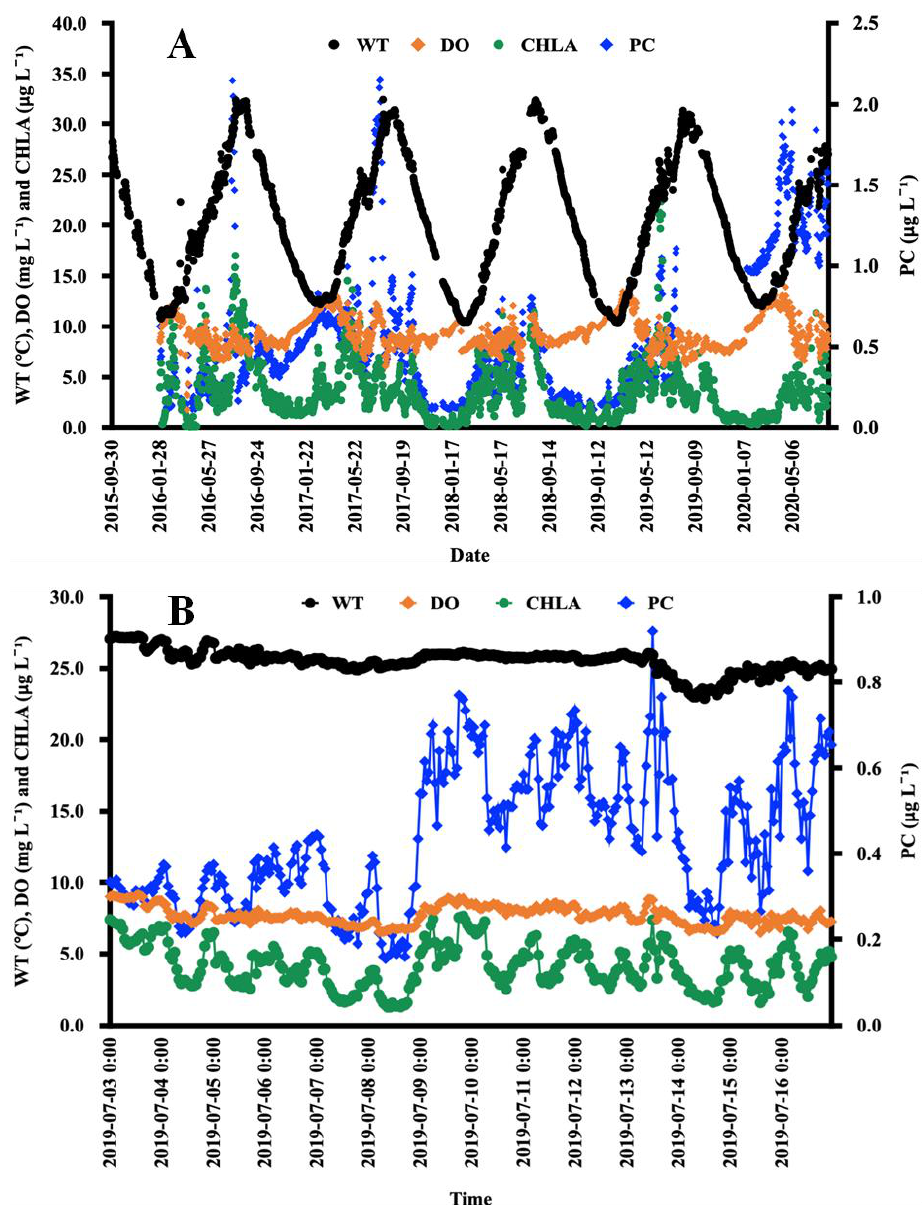
Figure 3. Time serials of ( A ) daily and ( B ) hourly WT (black dots, ℃ ), DO (orange diamonds, mg L −1 ), CHLA (green dots, µg L −1 ) and PC (blue diamonds, µg L −1 ) at site 5. Left Y-axes is for WT, DO and CHLA, and right Y-axes is for PC. X-axes is for date in format of year-month-day. To show diel variation, hourly data of WT, DO, CHLA and PC at site 5 for the period of 00:00 a.m. 3 July 2019 – 11:00 p.m. 16 July 2019, without data gaps, are presented as an